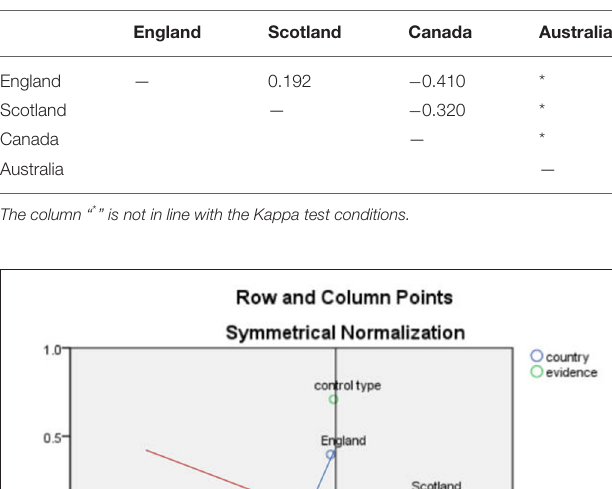
TABLE 2 | Kappa consistency test scores for the four country assessments.